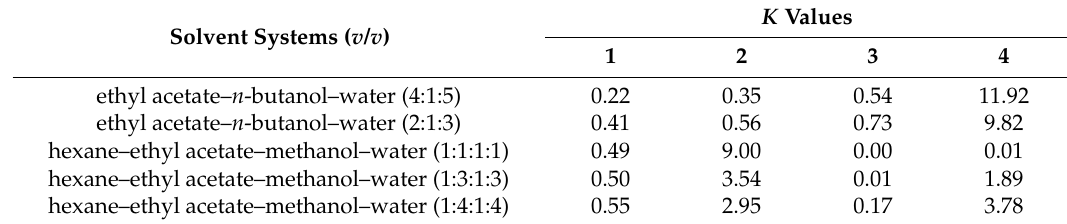
Table 1. K values of the four compounds in different two-phase solvent